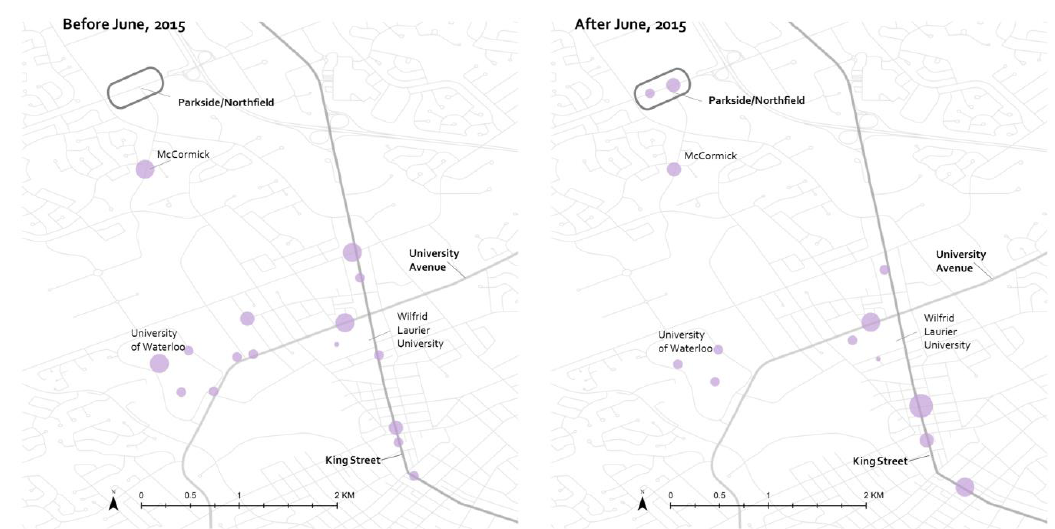
Figure 11. The comparisons of bus service-related tweets before and after June 2015.